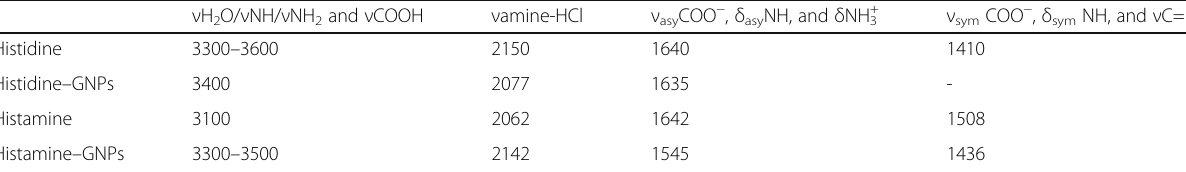
Table 1 FTIR bands of histidine, histidine – GNPs, histamine, and histamine –